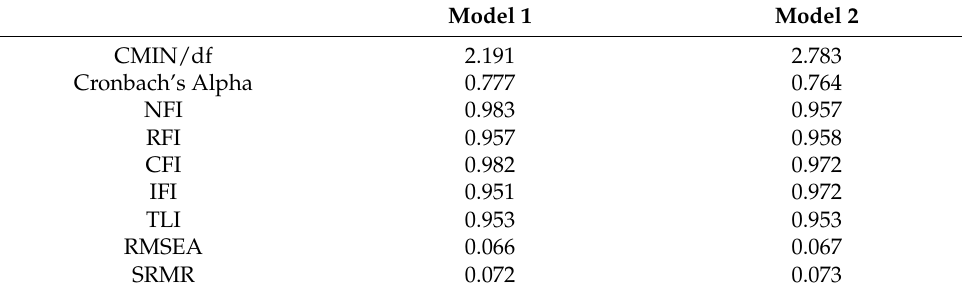
Table 5. Measures of the fit index for CFA.